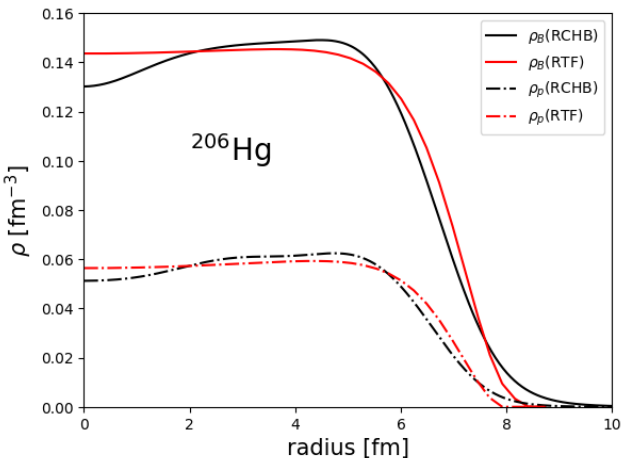
Figure 1. Comparison between density distributions obtained from the RCHB (black) (with bubble structure) and the RTF (red) (without bubble structure) calculations for 206 Hg. With the RCHB theory, the DF factors for the total and proton densities are 13% and 18%,